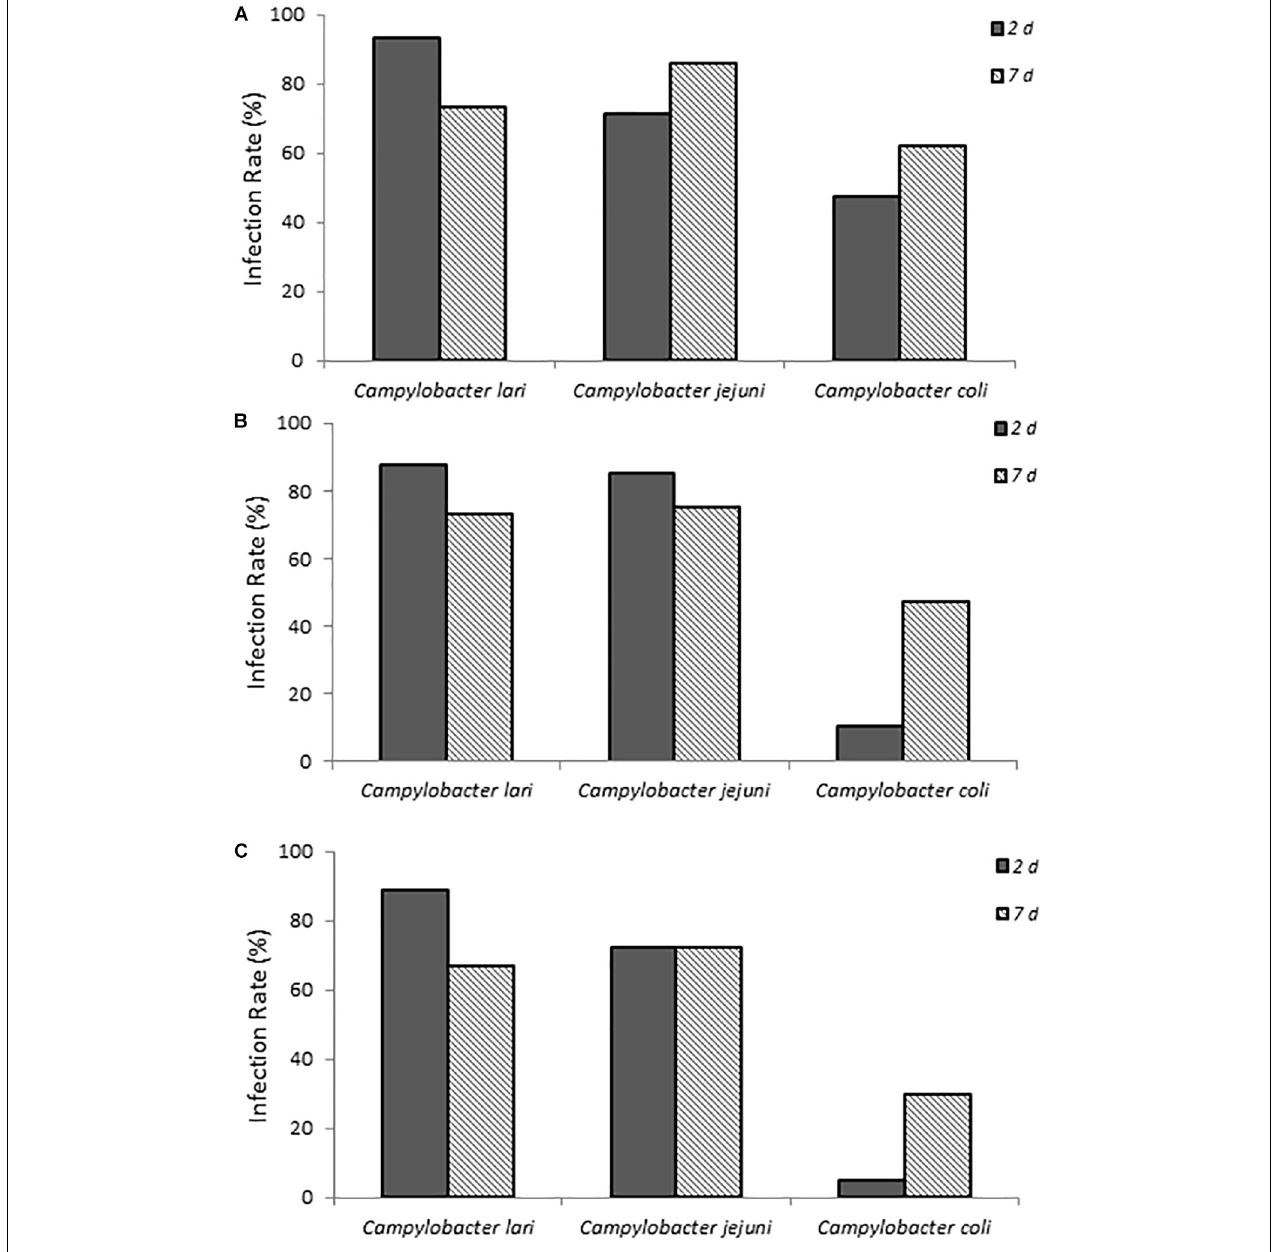
FIGURE 1 | Infection rates of laboratory isolates of Campylobacter spp. (A–C) show chicks infected with dose A, B, and C Campylobacter spp., respectively. Percent infected was determined by dividing the number of infected chicks by the total number of chicks inoculated with the various Campylobacter species. Chicks were considered infected if fecal samples collected at the various times were positive for Campylobacter spp. as determined by using the passive-filter plating described in section “Materials and